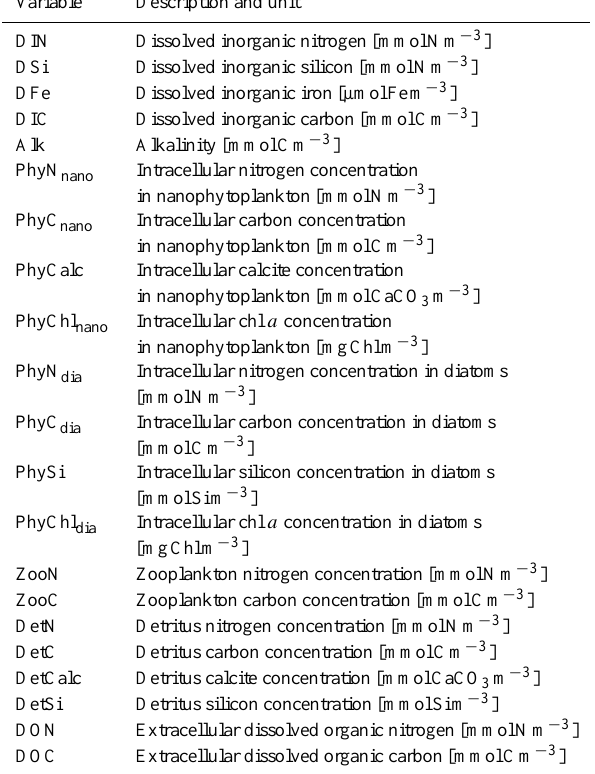
Table A1. State variables;